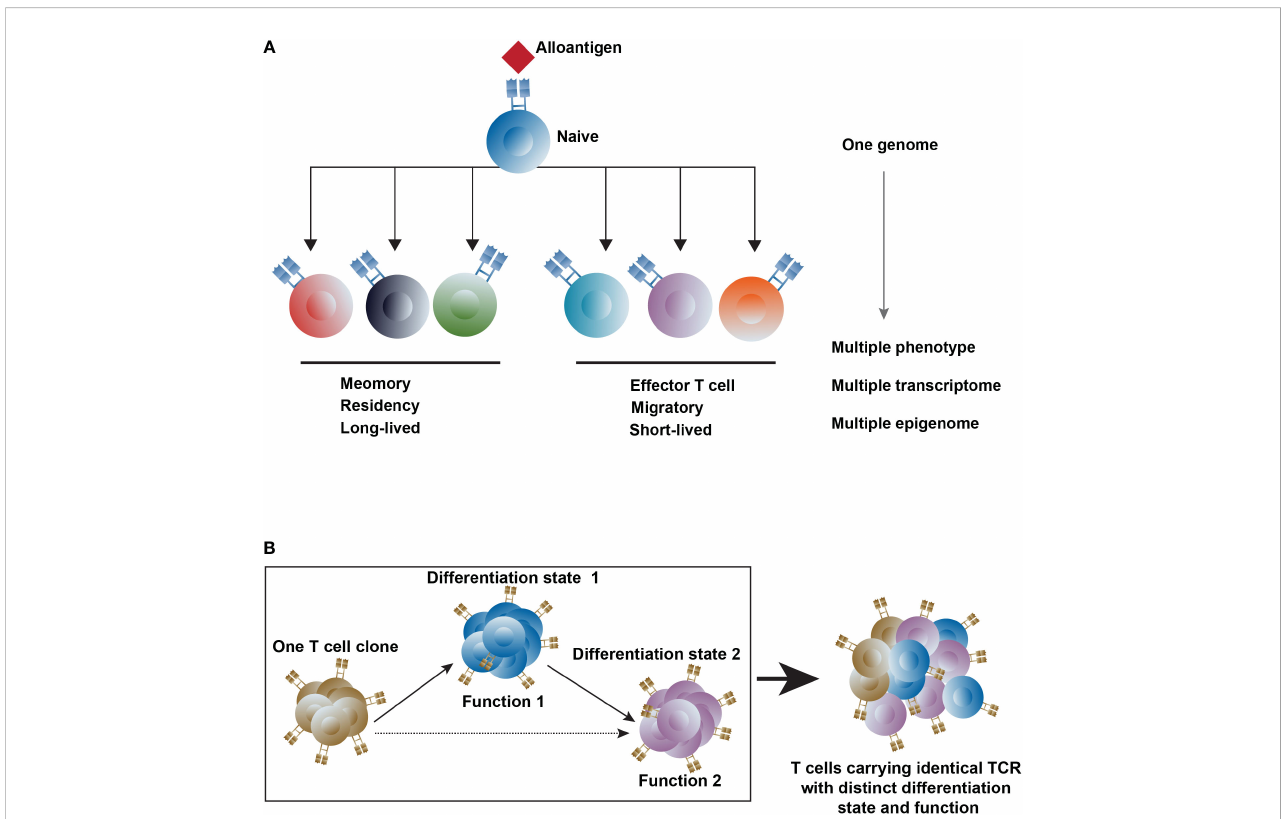
FIGURE 1 The heterogeneity of T cells. (A) T-cell differentiation states are regulated by epigenetics upon interacting with external factors (B) Trace the T cell clones with different differentiation states and functions after transplantation. Differentiation state1, 2 represents different differentiation states, and Function1, 2 represents T cells with a different function. The dashed line represents the potential differentiation